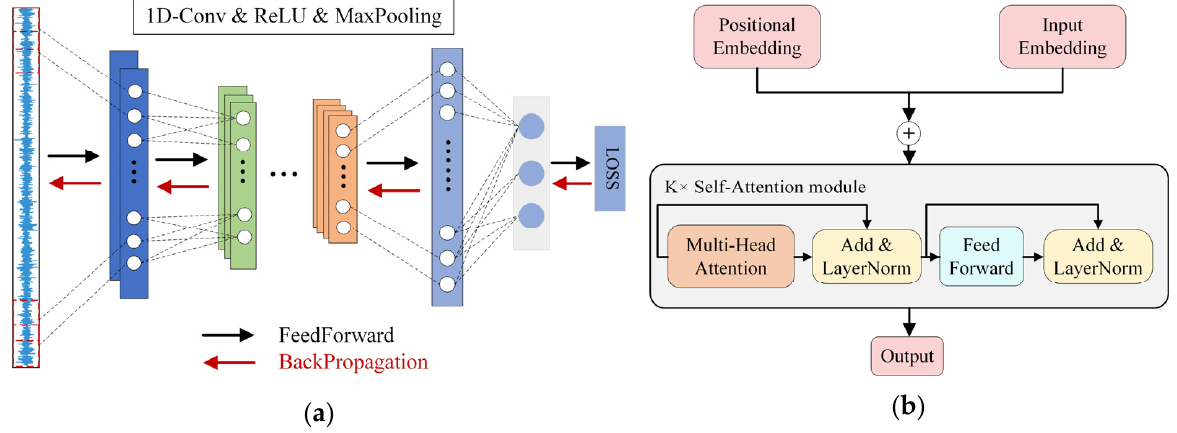
Figure 1. Comparison of CNN and self-attention structure. ( a ) CNN model structure. ( b ) Self-attention model structure.